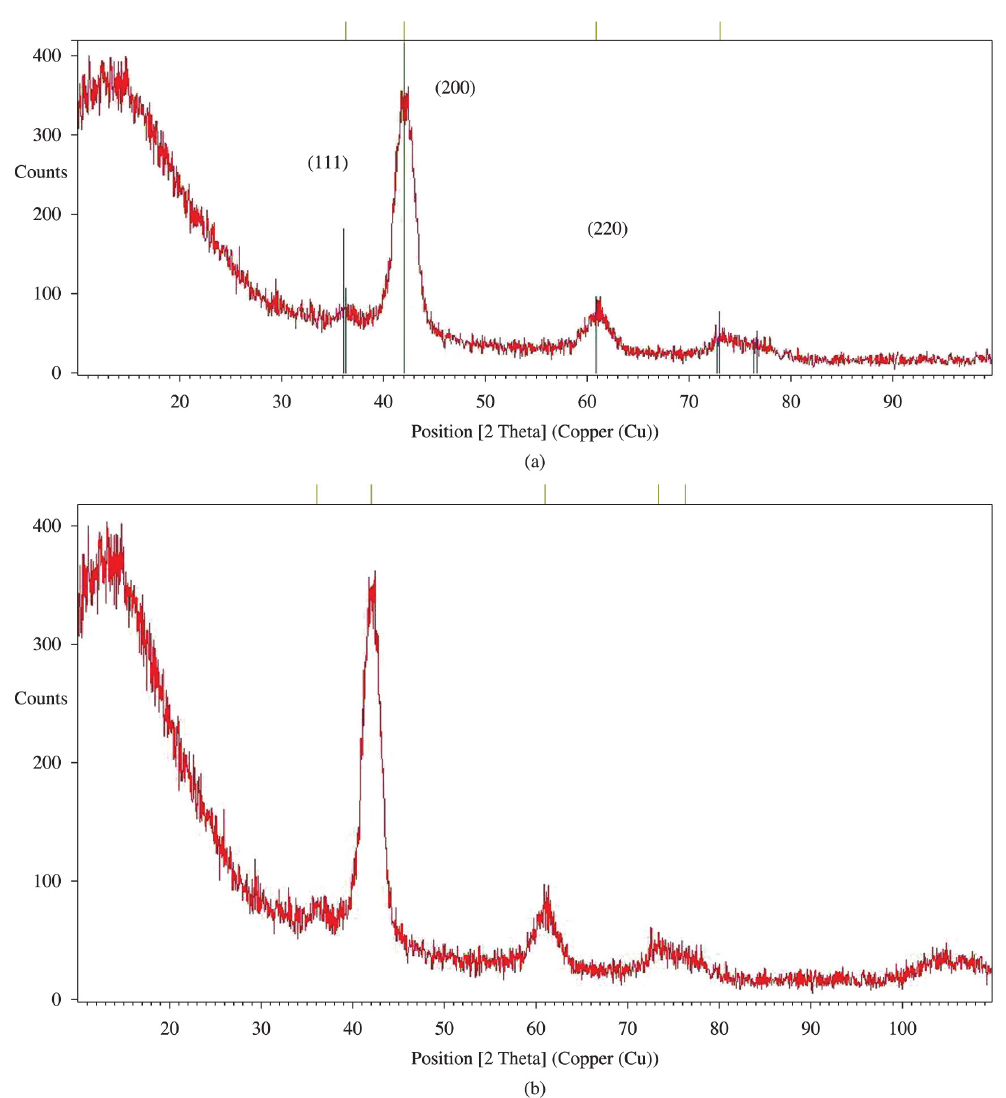
Figure 1. GIXRD patterns acquired from the TiCxNy coatings using the two gas mixtures CH4/ (CH4+N2). a)0.66 and b)0.5.